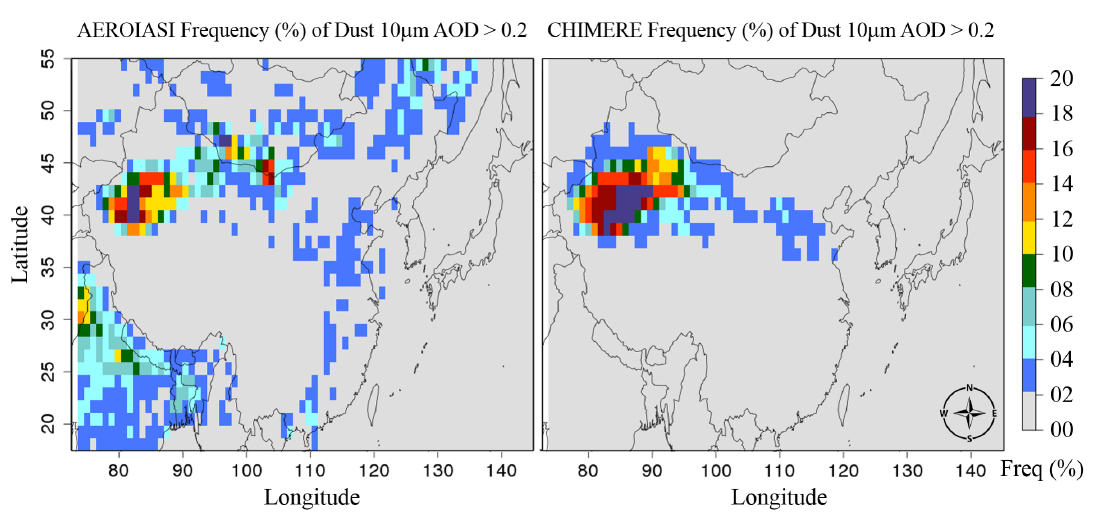
Figure 3. ( left ) AEROIASI Frequency (%) of daily dust 10 µ m AOD > 0.2. ( right ) CHIMERE Frequency (%) of daily dust 10 µ m AOD > 0.2. Frequencies are calculated over daily value for 2011, 2013 and